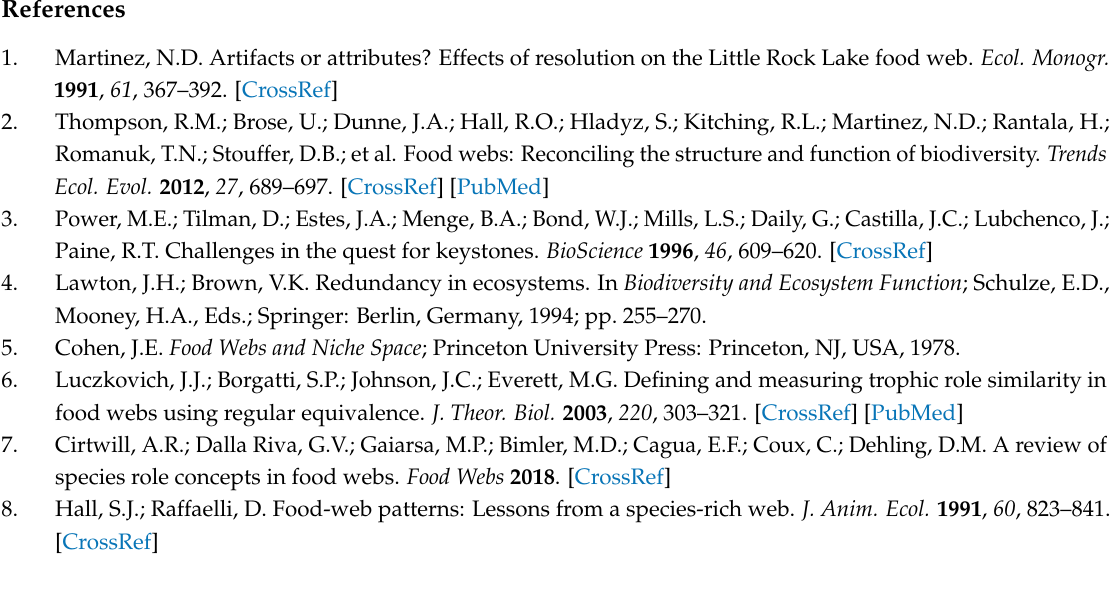
Table S1: The adjacency matrix (A), the REGE half matrix (B), the TI matrix (C) and the TO half matrix for the Gulf of Naples network. For REGE and TO we also present the ranking of the nodes. Table S2: The ranking of nodes based on their TO-values for different thresholds ( T = 0.01, 0.02, 0.03, 0.04, 0.05, 0.06). Table S3: The ranking of nodes based on their STO-values for different thresholds ( T = 0.01, 0.02, 0.03, 0.04, 0.05, 0.06). Table S4: The identity of graph nodes in the Gulf of Napoli food web. Figure S1: Correlations between TO and STO for several threshold values. Figure S2: Correlations between TO and REGE for several threshold values. Figure S3: Correlations between STO and REGE for several threshold values. Figure S4: The position of the not aggregated (A: #62; B: #41) or only weakly aggregated (C: #29 and #56) trophic groups in the TO/REGE plain. All organisms aggregated into E (everything else) are shown. Based on the “ bv ” aggregation (see Table 2). The plots are shown for 6 threshold values. Figure S5: The position of the not aggregated (A: #49; B: #54; C: #56; D: #52) trophic groups in the TO/REGE plain. All organisms aggregated into E (everything else) are shown. Based on the “ cv ” aggregation (see Table 2). The plots are shown for 6 threshold values. Figure S6: The position of the not aggregated (A: #56; B: #52) or only weakly aggregated (C: #50 and #57; D: #45, #46, #47, #48 and #51) trophic groups in the TO/REGE plain. All organisms aggregated into E (everything else) are shown. Based on the “ sv ” aggregation (see Table 2). The plots are shown for 6 threshold values. Figure S7: The position of the not aggregated (A: #62; B: #41) or only weakly aggregated (C: #29 and #56) trophic groups in the STO/REGE plain. All organisms aggregated into E (everything else) are shown. Based on the “ bv ” aggregation (see Table 2). The plots are shown for 6 threshold values. Figure S8: The position of the not aggregated (A: #49; B: #54; C: #56; D: #52) trophic groups in the STO/REGE plain. All organisms aggregated into E (everything else) are shown. Based on the “ cv ” aggregation (see Table 2). The plots are shown for 6 threshold values. Figure S9: The position of the not aggregated (A: #56; B: #52) or only weakly aggregated (C: #50 and #57; D: #45, #46, #47, #48 and #51) trophic groups in the STO/REGE plain. All organisms aggregated into E (everything else) are shown. Based on the “ sv ” aggregation (see Table 2). The plots are shown for 6 threshold